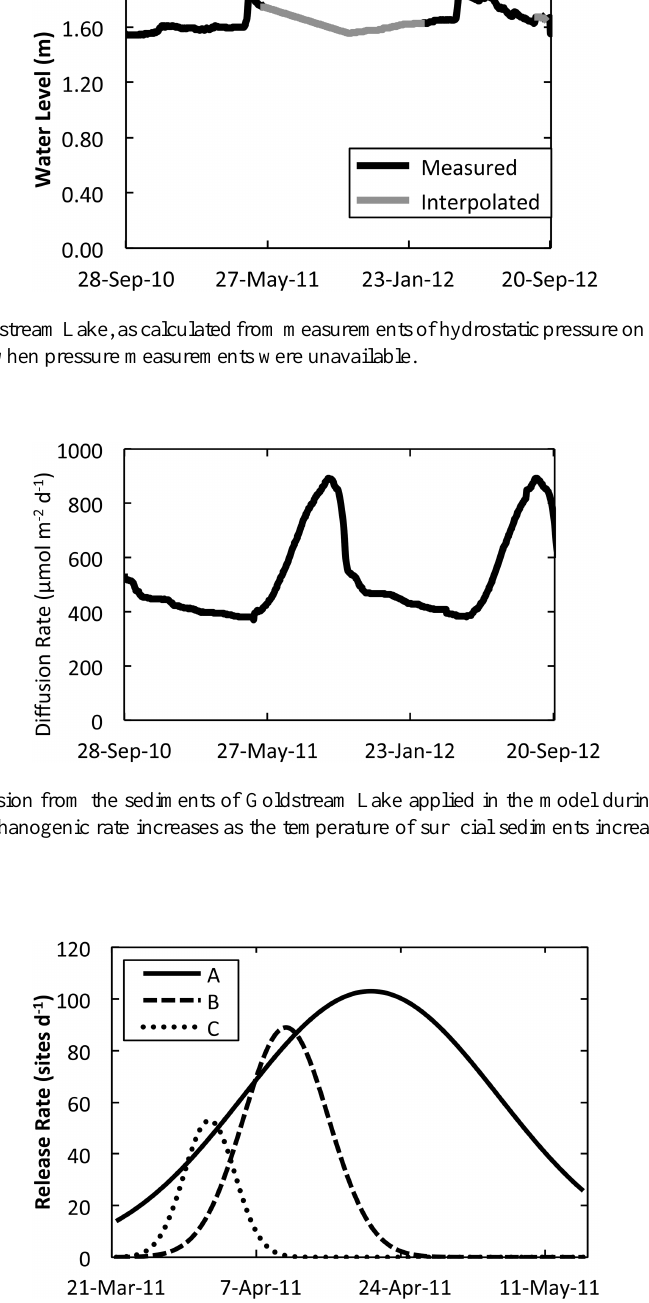
Figure B3. The rates at which sites in each ebullition class were opened to the atmosphere during the 2011 spring melt period, as informed by field observations. Rates for the 2012 spring melt period followed the same general pattern. The peak release rate of C seep sites occurred before those of A and B seep sites because a greater volume of encapsulated gas was observed at C seep sites. The total area beneath each curve is equal to the number of seeps of each type observed in Goldstream